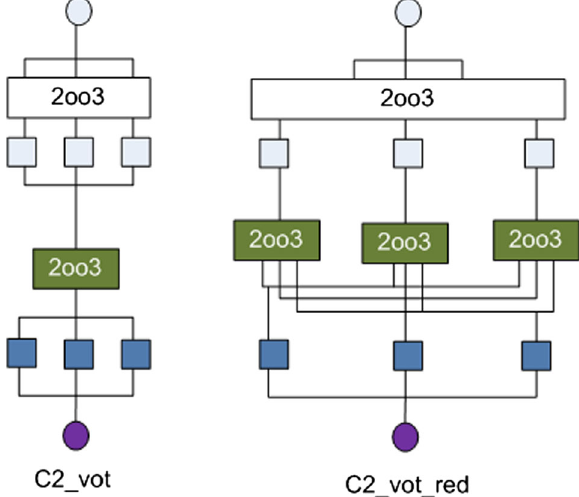
FIG. 18. Models underlying Case III, featuring redundancy for (error-prone) voting components.